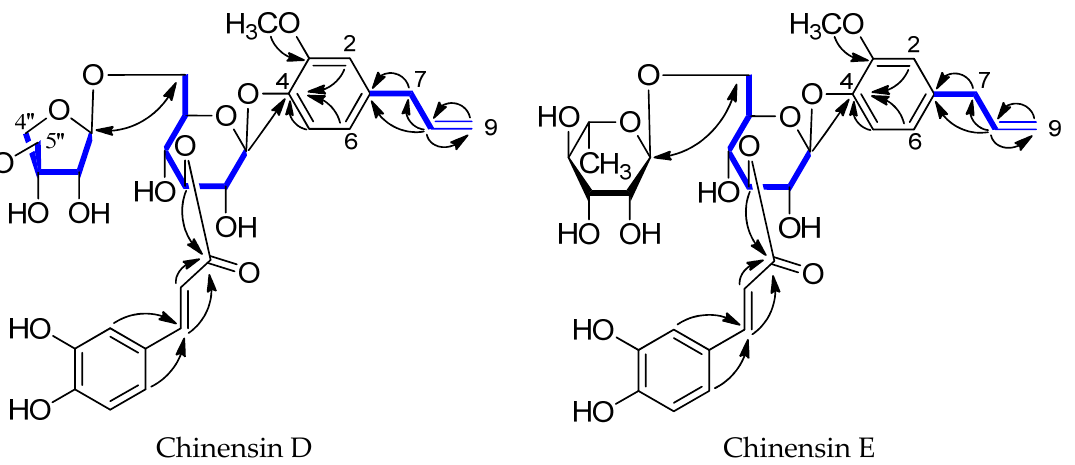
Figure 5. Structure and selected HMBC, 1 H- 1 H COSY correlations of Chinensin D and Chinensin E.